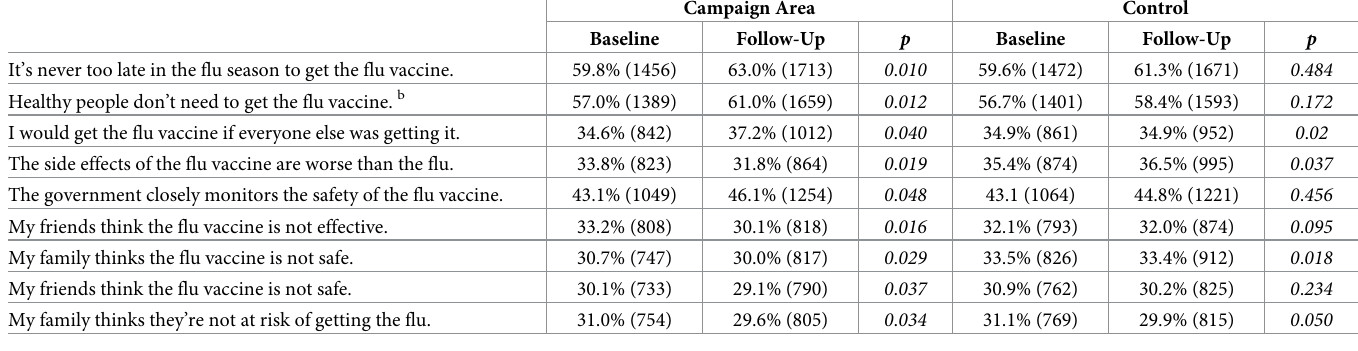
Table 3. Statements of agreement for social norms regarding the flu vaccine at baseline and follow-up, campaign area versus control a .